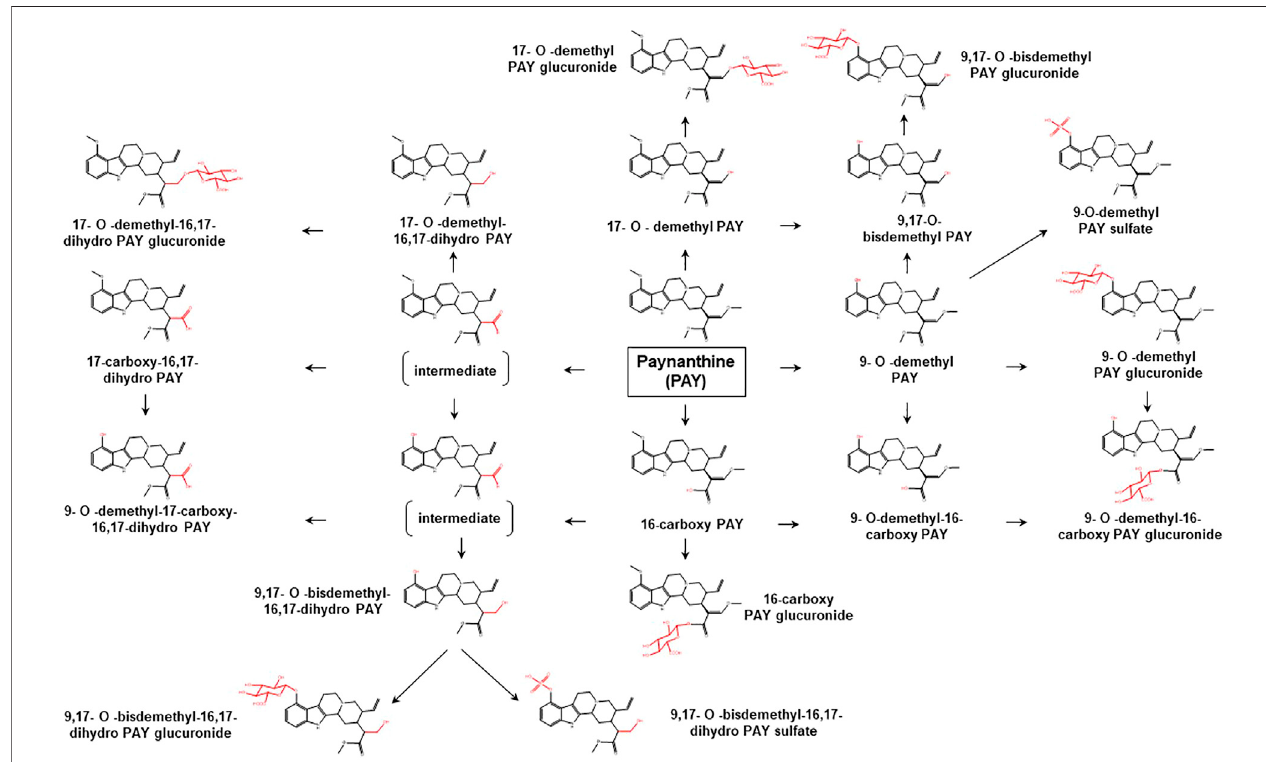
FIGURE 3 | Proposed metabolic pathways of PAY based on data obtained in rodents and humans. Structures highlighted in red denote structural transformation from parent molecule PAY. Figure was modi fi ed from Philipp et al. (2010a).